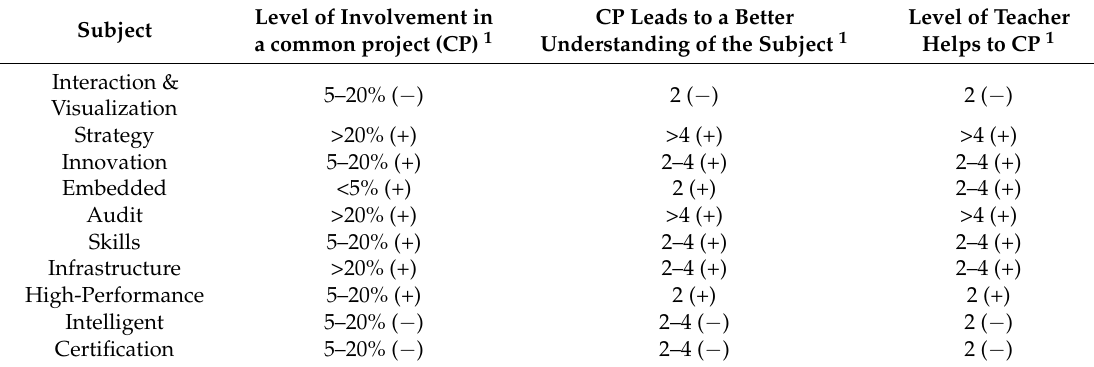
Table 6. Classification of subjects according to their requirement level and student